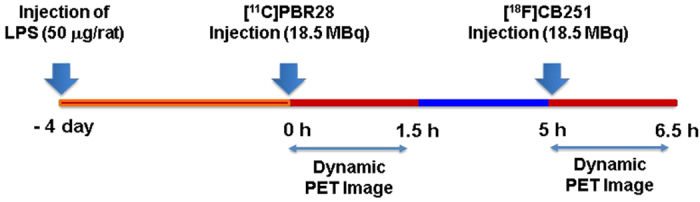
Experimental design of the PET imaging study.